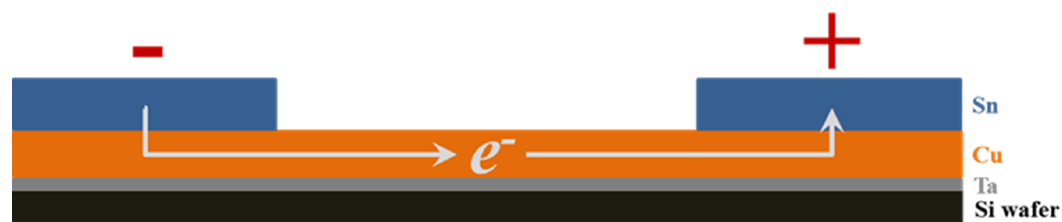
Figure 5. Path diagram of heat and current.